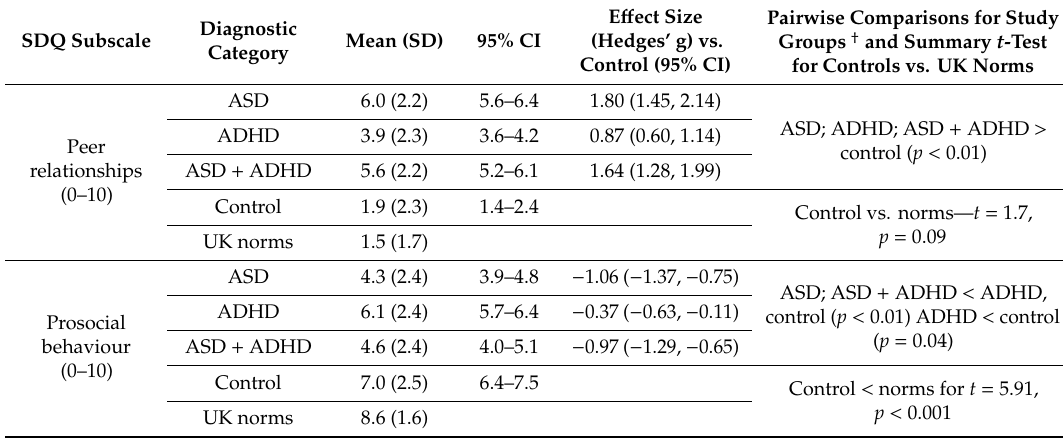
Figure S1: SDQ total scores, Figure S2: SDQ emotional symptoms, Figure S3: SDQ conduct problems, Figure S4: SDQ hyperactivity, Figure S5: SDQ peer problems, Figure S6: SDQ prosocial behaviour, Table S1: Comparison of strengths and di ffi culties questionnaire data for COVID-19 lockdown clinical group ( n = 371) versus a UK clinical (pre-COVID-19) clinical mental health sample ( n =